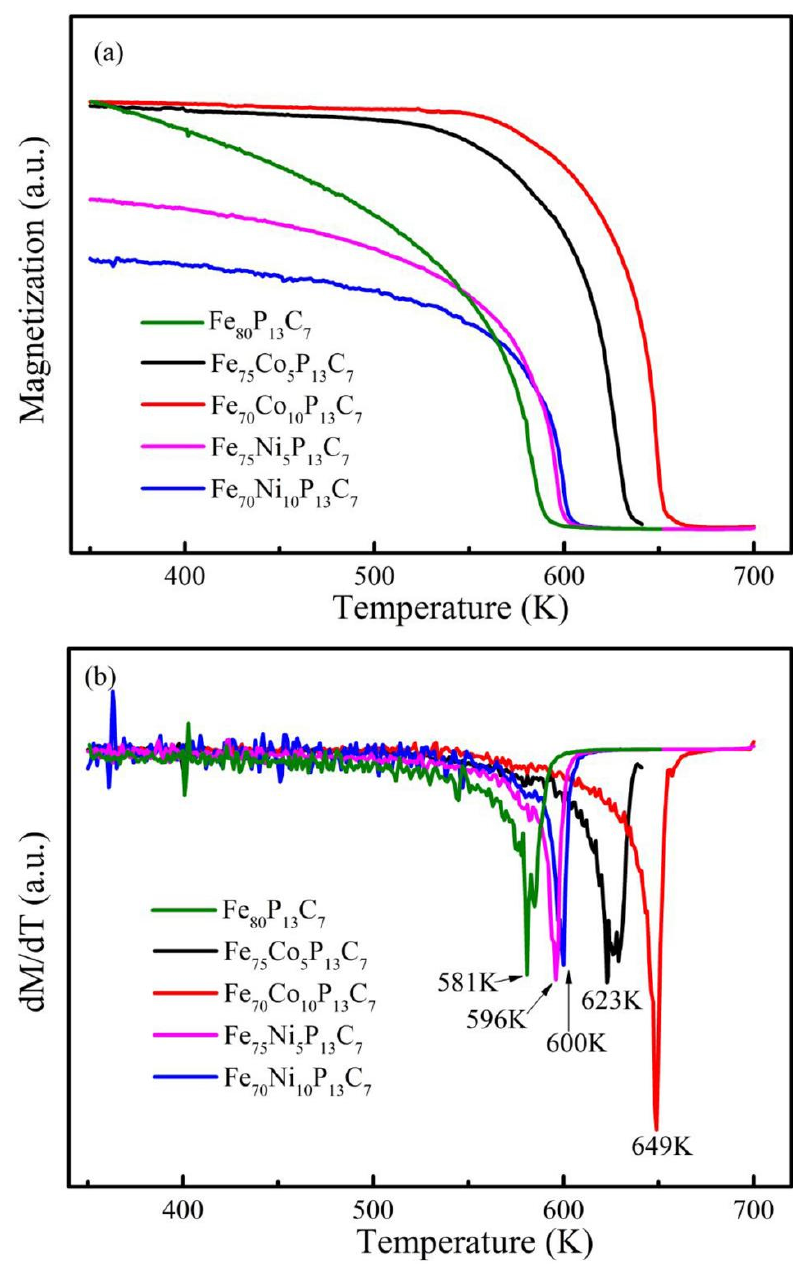
Figure 4. Temperature varies with magnetization ( a ) and d M /d T ( b ) of as-cast Fe 80-x M x P 13 C 7 (M = Co, Ni; x = 0, 5 and 10 at.%) glassy alloy rod samples. The isothermal magnetization curves of the Fe 80-x M x P 13 C 7 (M = Co, Ni; x = 0, 5 and 10 at.%) glassy alloy rod samples at the magnetic applied fields of 1.5 to 5 T are shown in Figure 5. When the test temperature is below T C , the samples reach the magnetization saturation under low applied magnetic fields, but when the temperature gets close to or above T C , the M - H curves of the samples become linear, indicating that the samples turn from ferromagnetic to paramagnetic state [23].